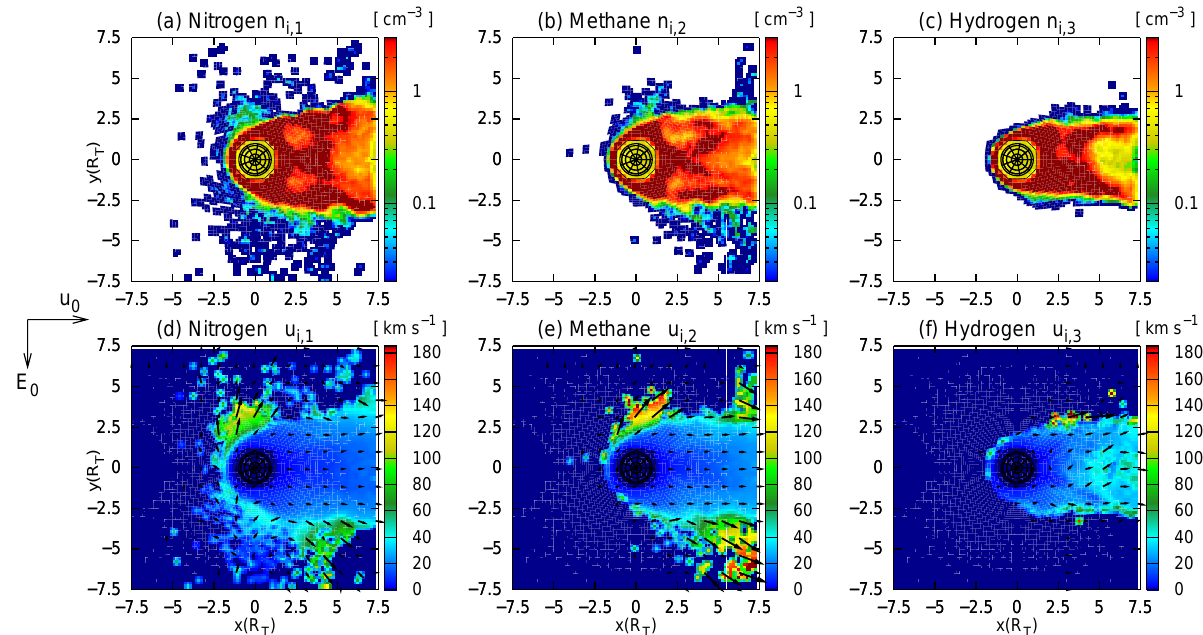
Fig. 4. Run #2 : Titan’s plasma environment when the satellite is exposed to a periodic distortion according to eqs. (8) and (9). The period T = 2 π/ω of the distortion is T = 1000 δt , where 1333 δt correspond to the duration in which the magnetospheric plasma would pass through the simulation box one time. The plot shows the ionospheric plasma densities n and velocities u that correspond to the preceding figure. The subscript i, 1 denotes the parameters of molecular nitrogen, whereas i, 2 and i, 3 represent the methane and molecular hydrogen component, respectively.